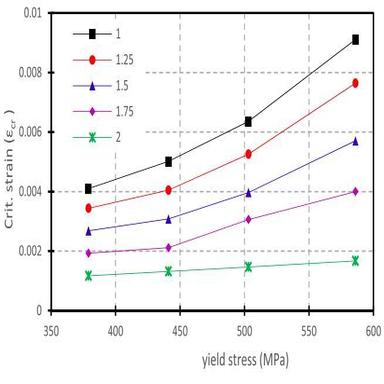
Plot of εcr vs. YS for DT4 pipe (fp = 0.8).